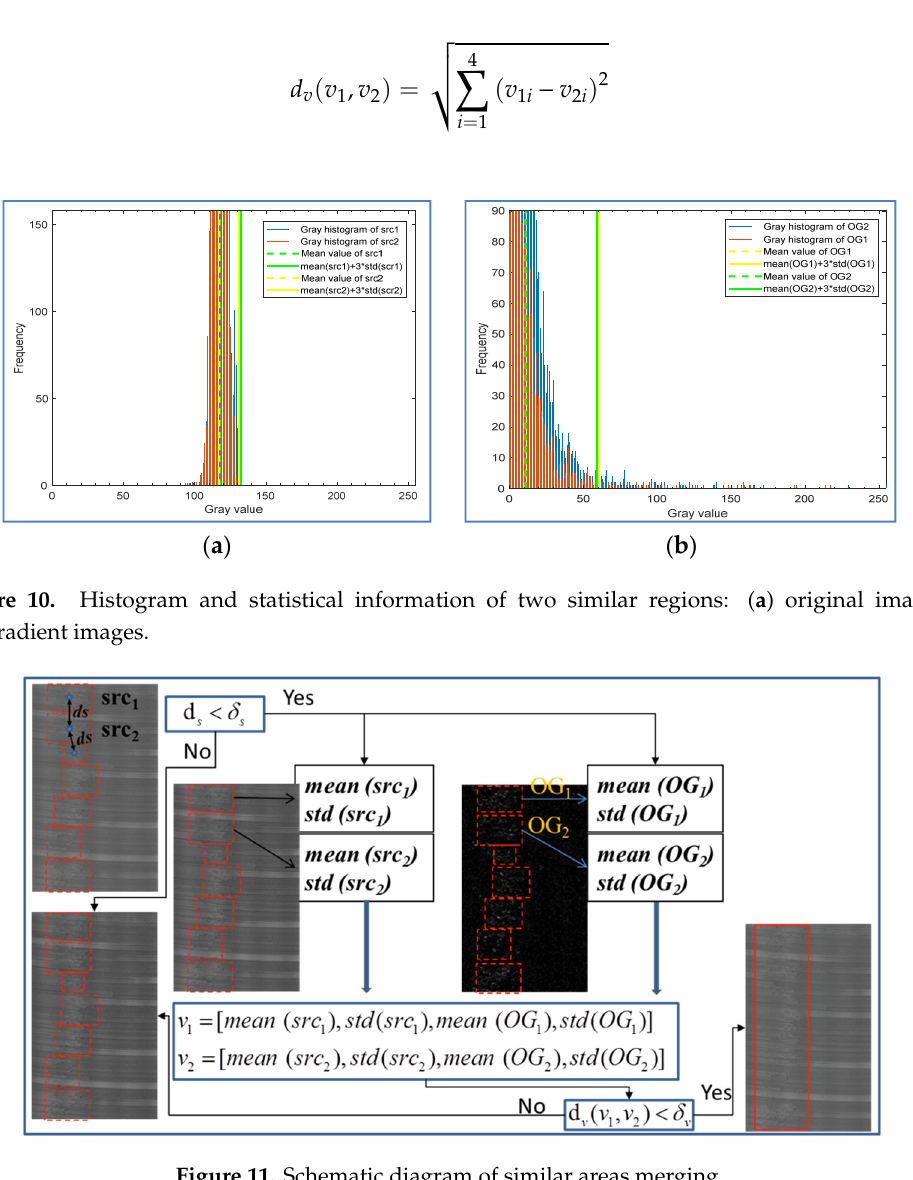
Figure 11. Schematic diagram of similar areas merging.